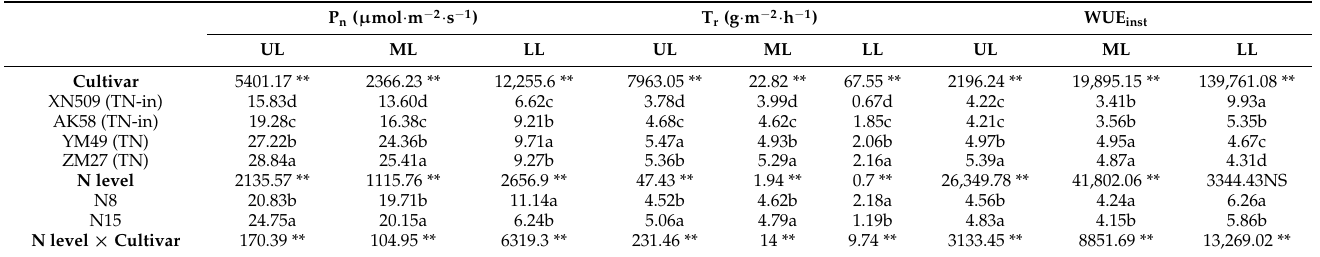
Table 6. The vertical distribution of P n , T r , and WUE inst of two N-efficient and two N-inefficient winter wheat varieties under different N